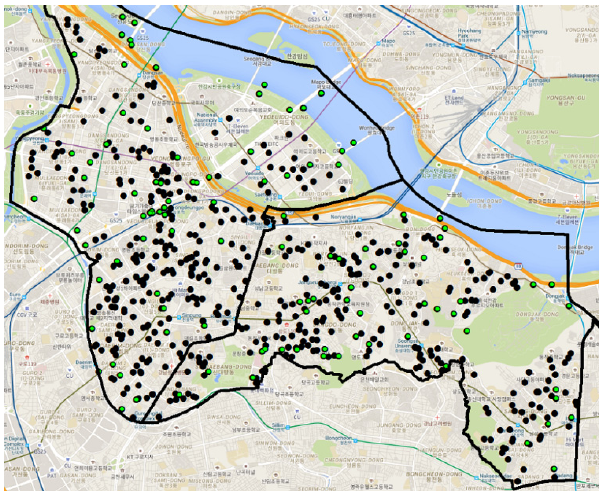
Figure 13. OHCA cases (total OHCA cases in black dots; outdoor OHCA cases in yellow dots). Table 3. Evaluation methods and results of the outdoor OHCA cases.